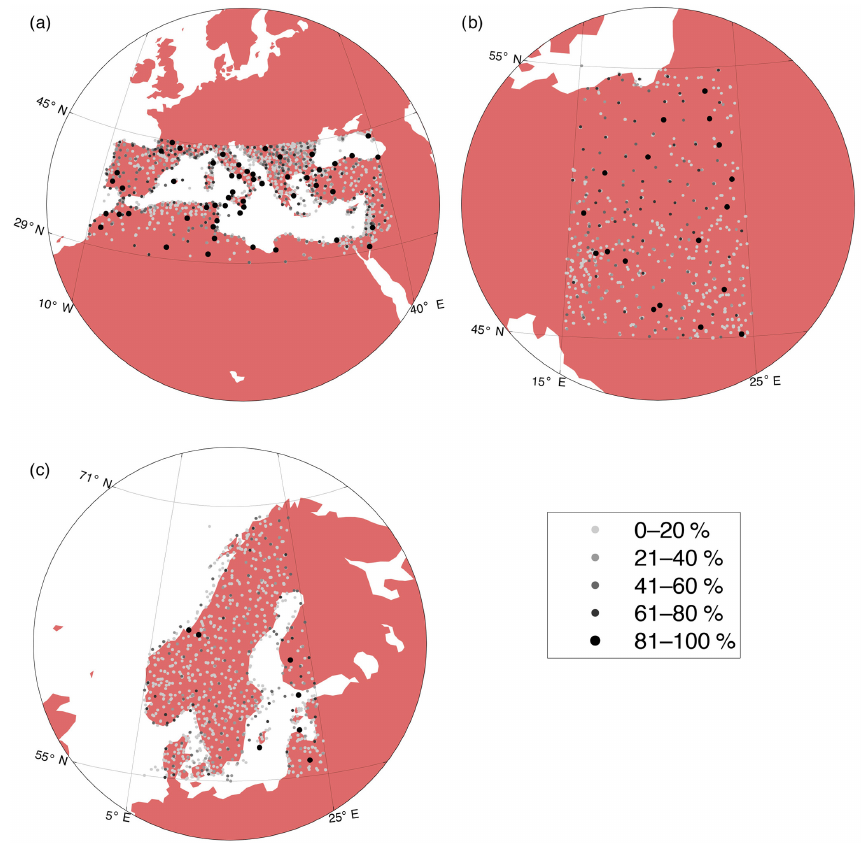
Figure 1. Stations with monthly mean sea level pressure data in MARS across the three identified regions of interest: (a) the Mediterranean, (b) eastern Europe and (c) Scandinavia. The shade and size of the symbols indicate the percentage of data available for